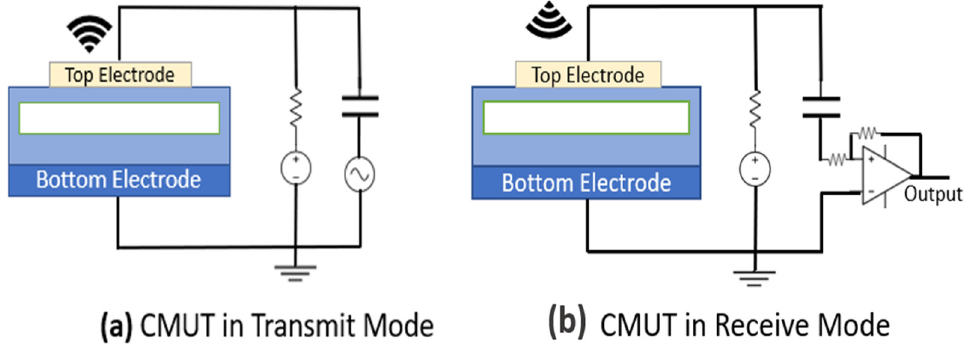
Figure 2. CMUT operation during ( a ) transmission and ( b ) reception.